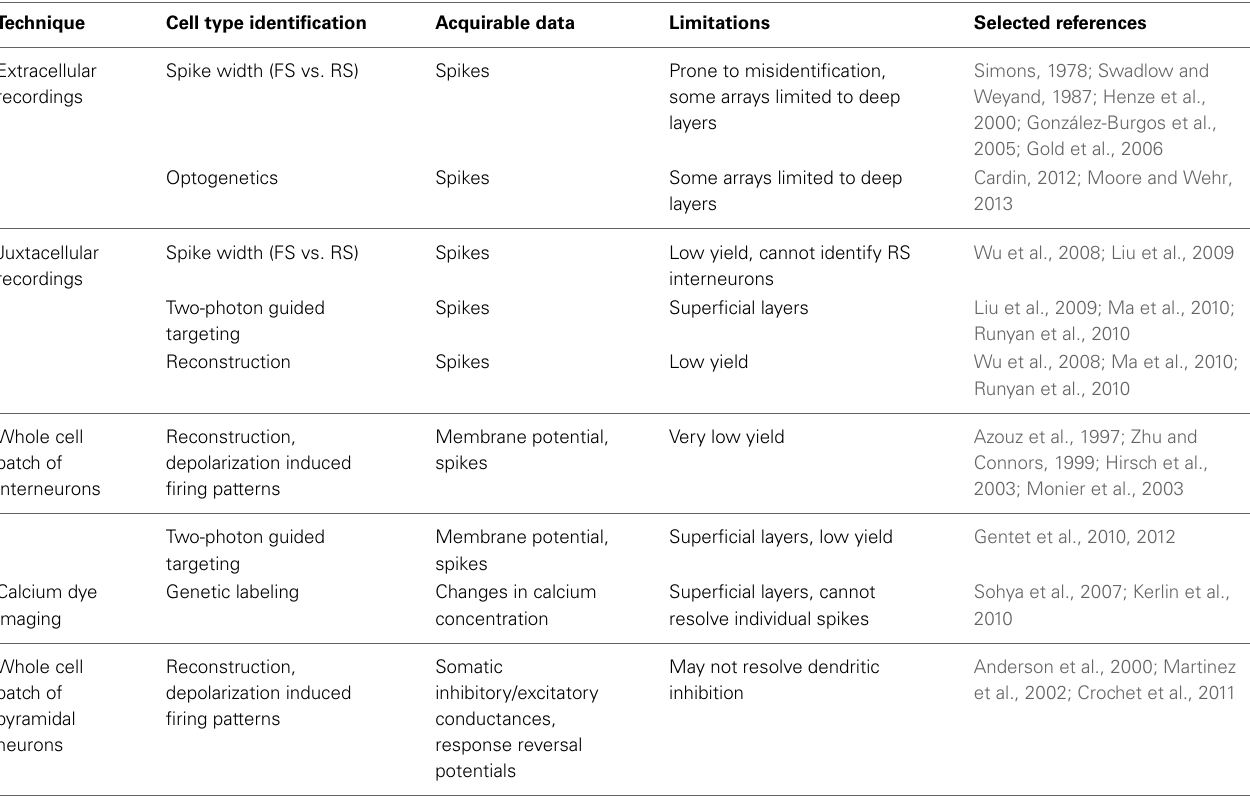
Table 1 | Approaches for recording the activity of inhibitory neurons and inhibitory postsynaptic responses in vivo